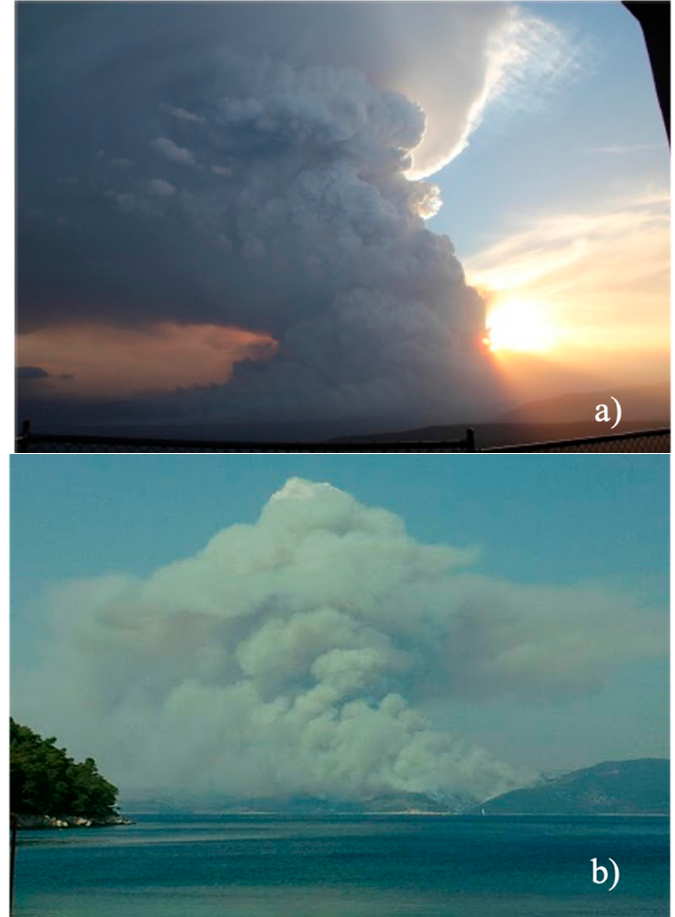
Figure 3. ( a ) Photo of pyrocumulonimbus cloud in the Grampians Fire, Victoria, Australia, 21 February 2014 (Photo taken by Randall Bacon; [33]), and ( b ) pyrocumulus or possible case of pyrocu- mulonimbus on the island of Braˇc, Croatia, 14 July 2011 (Photo taken by Siniša Miliˇci´c; [46]). Wildfires of this scale have not been reported in Croatia yet or with pyroCb